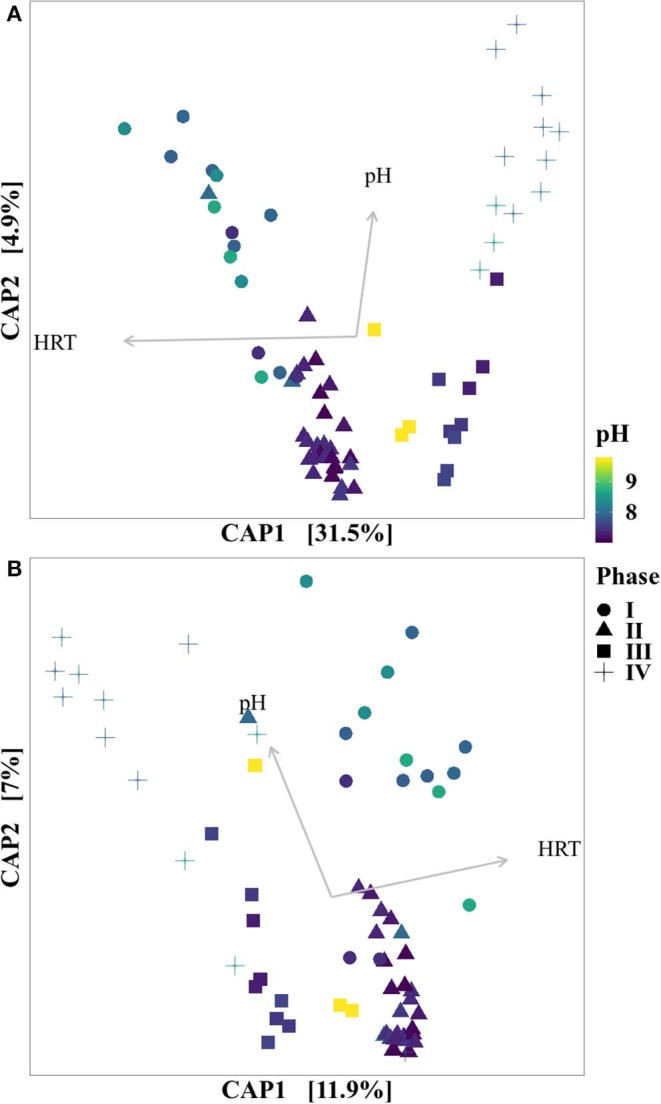
CAP plots for DNA (A) and cDNA (B). The colors indicate the different pH, while the shapes indicate to each phase the sample belongs.